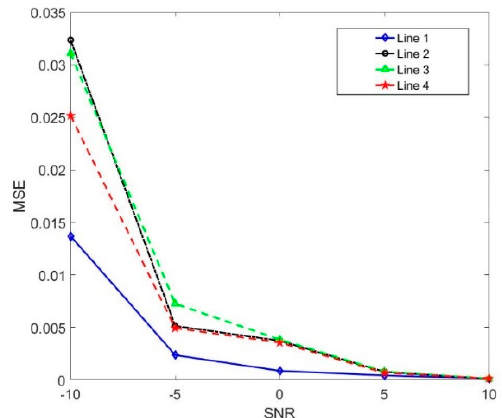
Figure 7. ( a ). MSEs of the four methods at − 10 dB < SNR < 10 dB (without reverberation). ( b ). MSEs of the four methods at − 10 dB < SNR < 10 dB (contain reverberation and the sound reflection coefficient is 0.25).